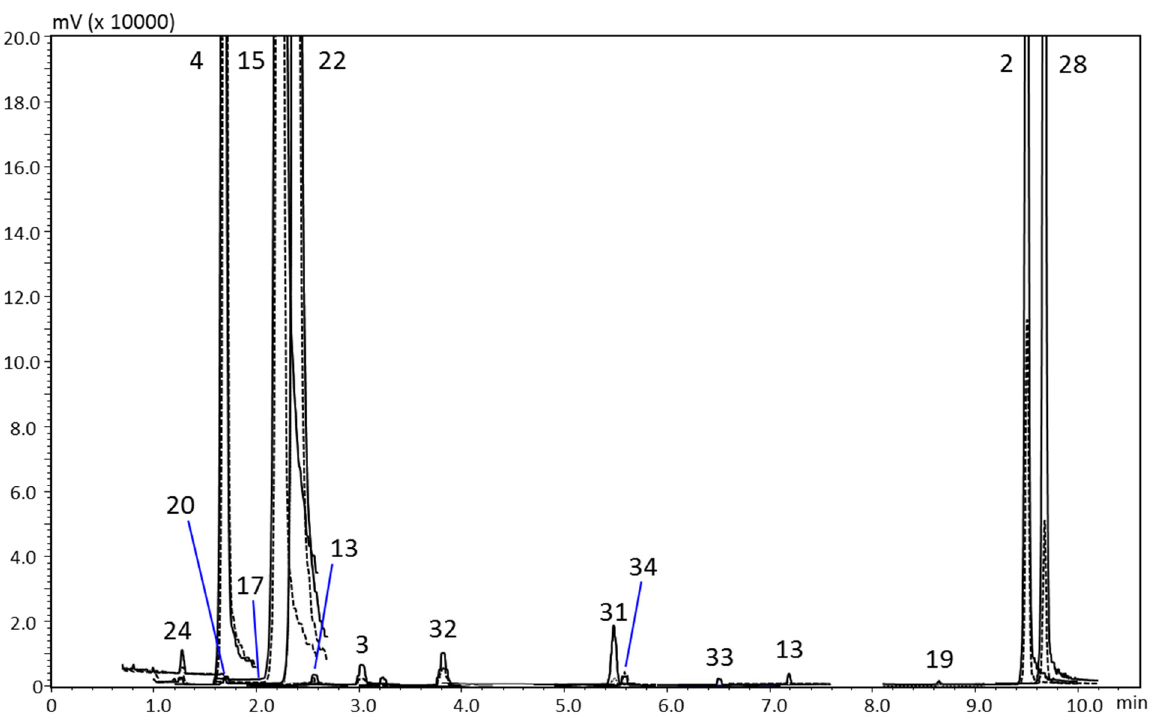
Figure 4. HPLC-MS/MS (MRM acquisition mode) chromatogram of the lemon marmalade. Quantifier ion, continuous line; qualifier ion, dotted line. For peak identification see Table 2.